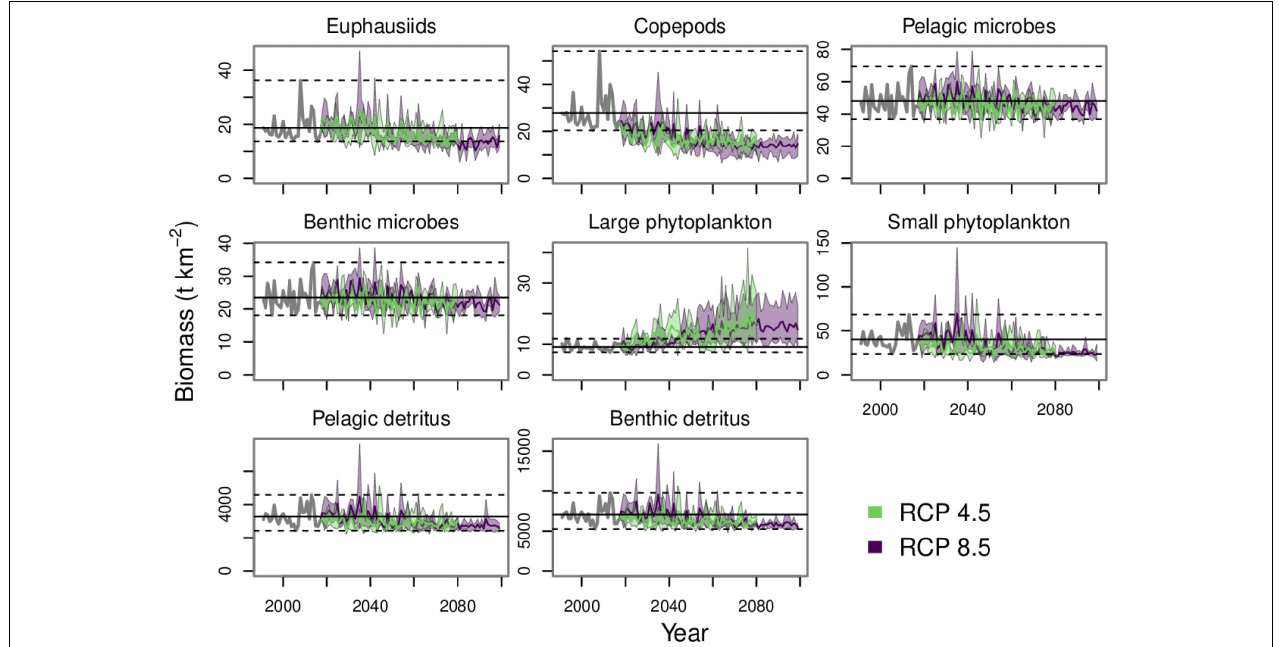
FIGURE 4 | Annual mean biomass projections for pelagic and benthic detritus and the projections for the functional groups forced with outputs from lower trophic level modeling (euphausiids, copepods, pelagic microbes, benthic microbes, large phytoplankton, and small phytoplankton). The gray lines from 1991 to 2017 indicates the historical period. The purple and green polygons indicate the minimum and maximum range for the three earth system models run under each RCP. The purple and green lines indicate the mean of the three runs for each RCP. The dashed lines indicate the minimum and maximum values from the historical period and the solid black line indicates the mean value from the historical